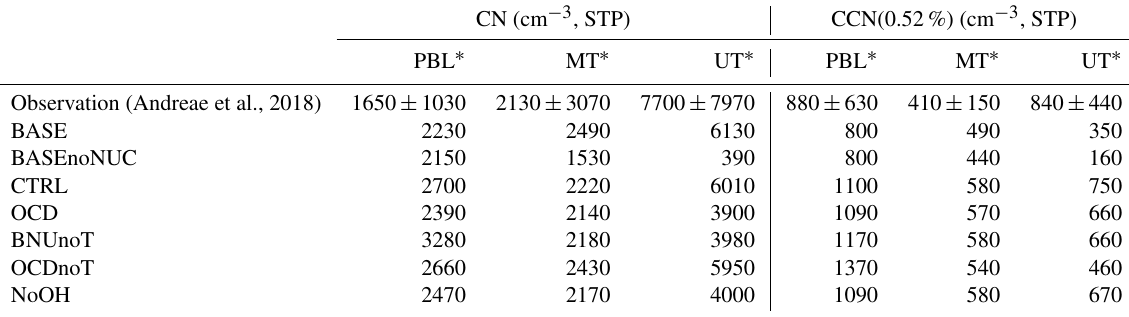
Table A4. Averaged values of modeled and observed aerosol particle number